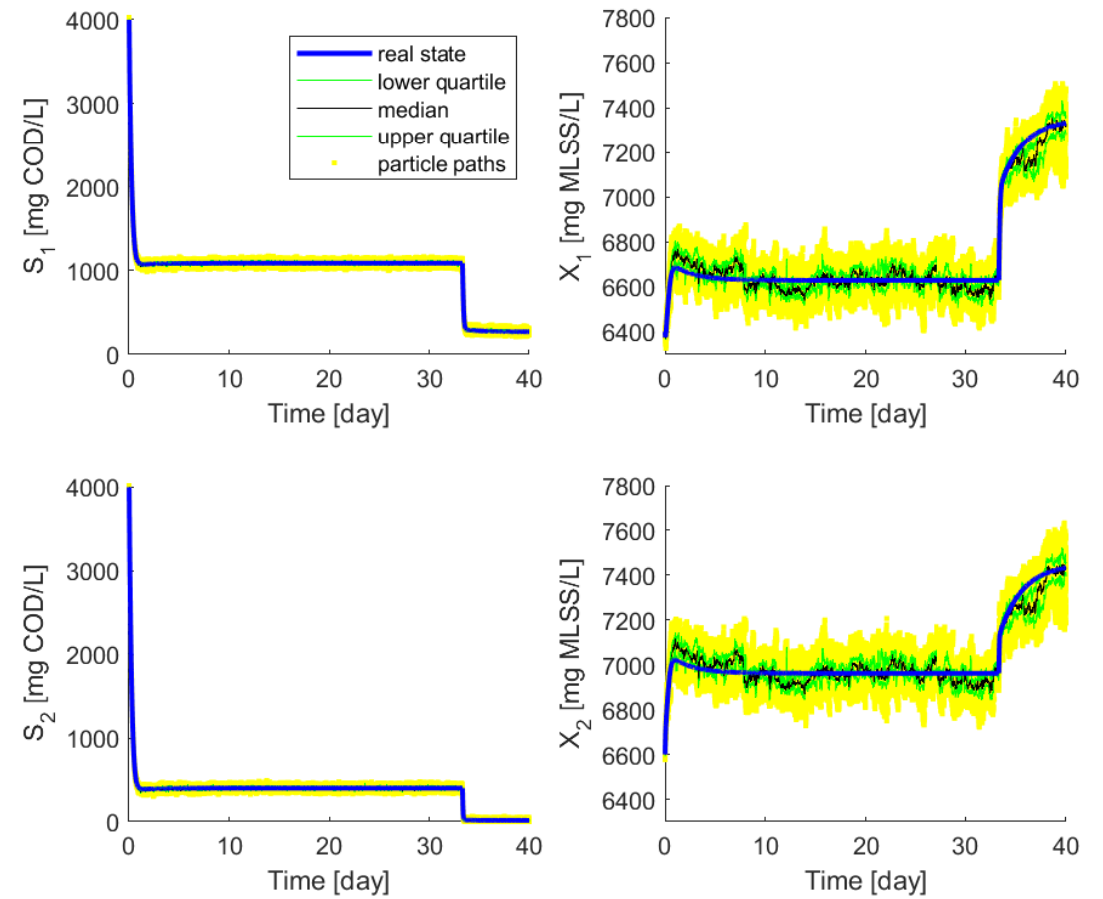
Figure 5. Comparison of the estimated and real states. The concentrations of the substrate are shown in mg COD/L and of the microorganisms in mg MLSS/L. Deviations of σ v = 10 and σ w = 25 were used for